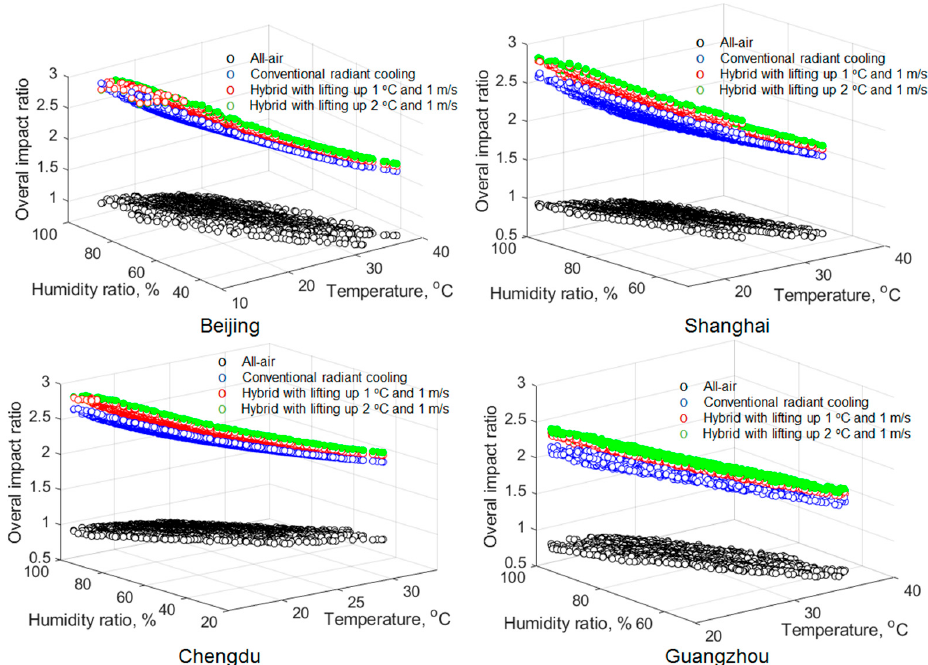
Figure 11. Overall impact ratio of three cooling systems in each city: upper left, Beijing; upper right, Shanghai; lower left, Chengdu; lower right, Guangzhou.